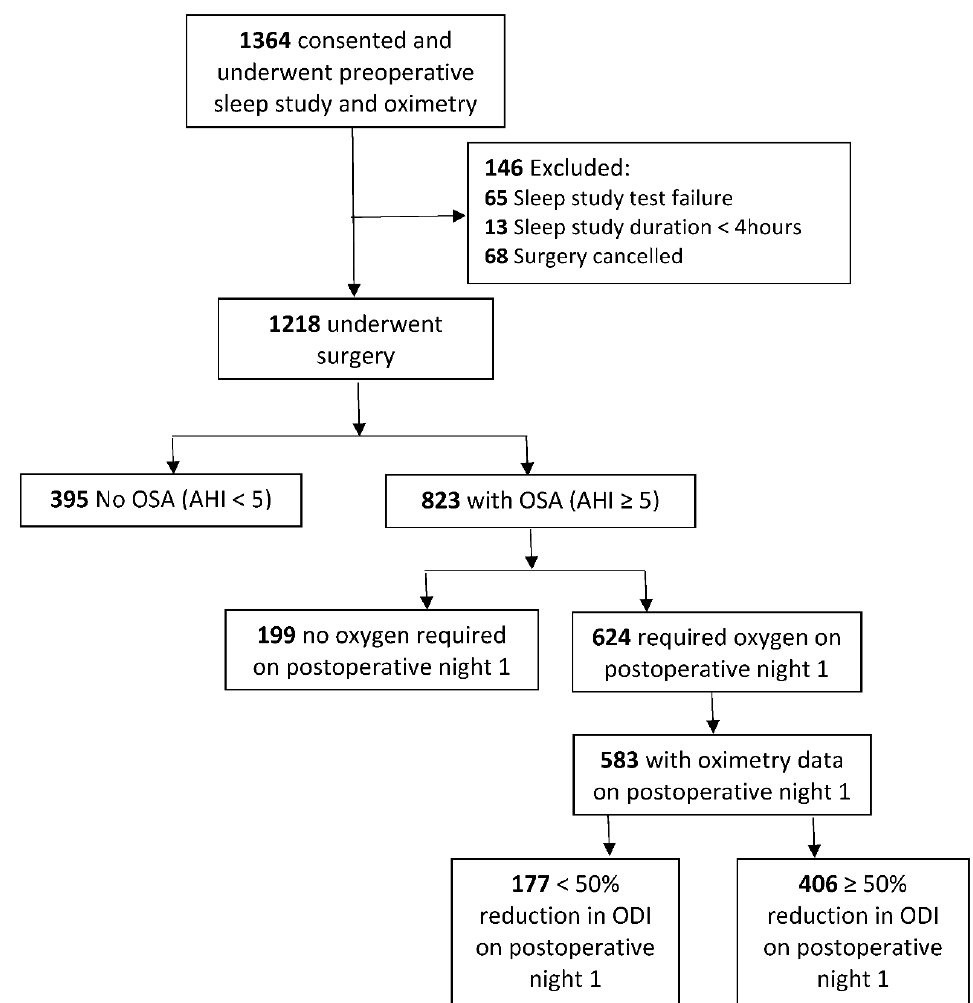
Figure 1. Study flow chart. Abbreviations: OSA, obstructive sleep apnea; AHI, apnea hypopnea index; ODI, oxygen desaturation